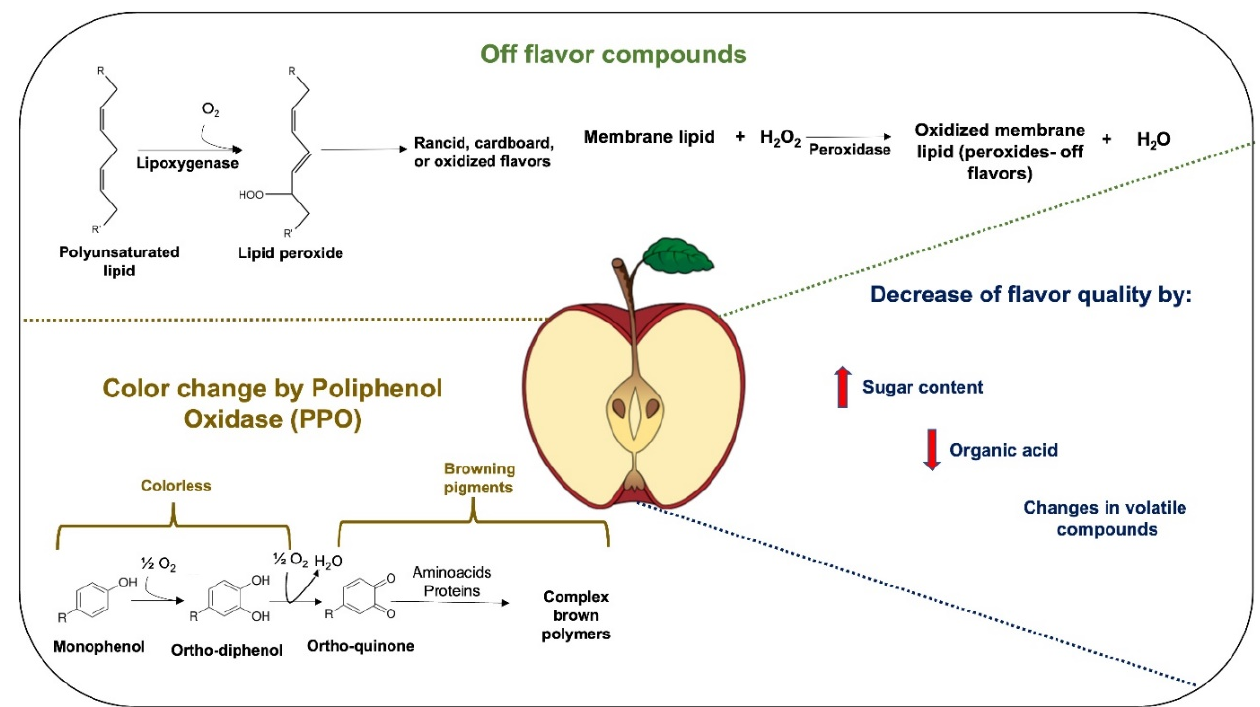
Figure 2. Enzymatic reactions and other factors that produce browning and off-flavors of fresh-cut fruits. The red up arrow indicates increase and the red down arrow indicates decrease.